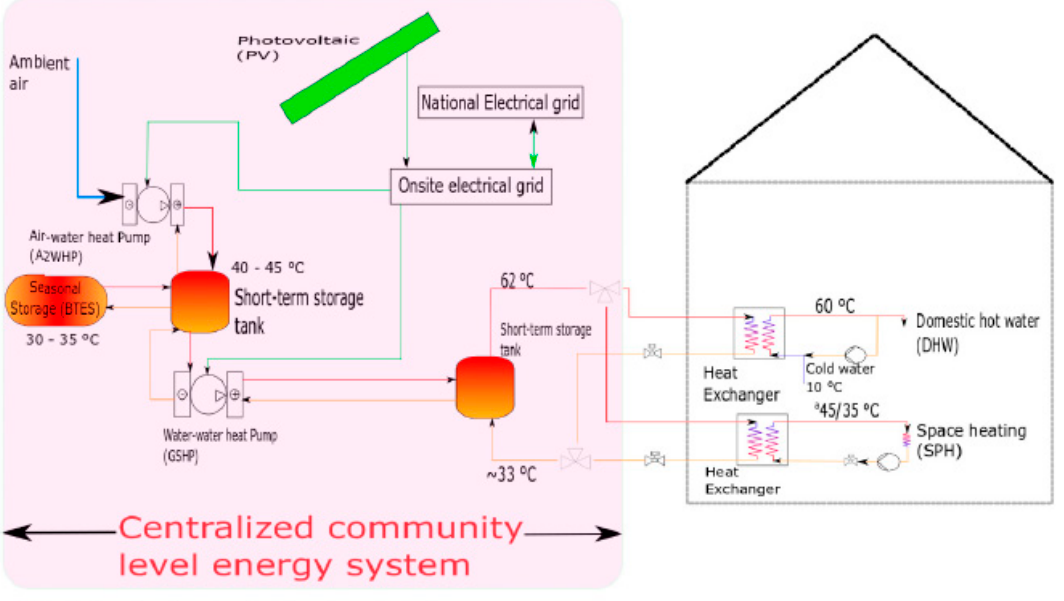
Figure 5. The schematic diagram of the centralized community-level district heating system for the old residential buildings based on PV, A2WHP, GSHP, and seasonal storage. (Case 3, PV + AW + GSHP + STR.